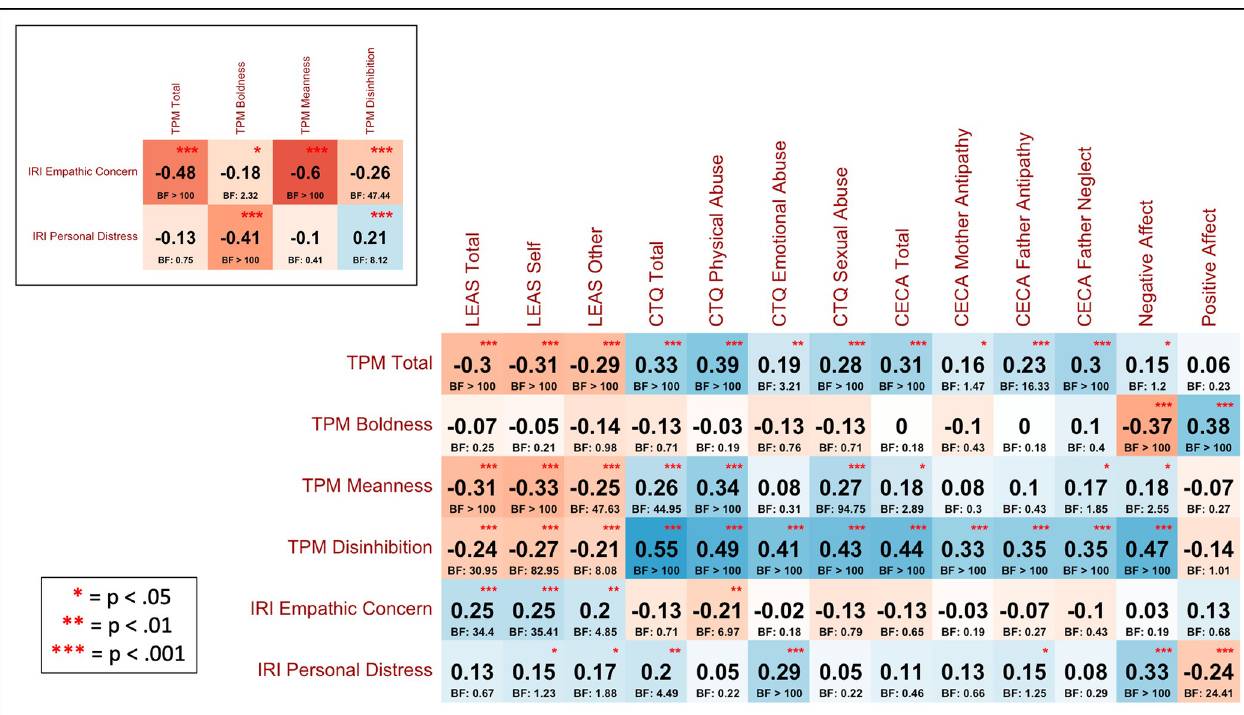
Fig 3. Correlations between measures. This figure shows post-hoc correlations (and associated BFs) across the full sample between additional subscales, illustrating their contributions to the main findings described in the text. Measures include the Levels of Emotional Awareness scale (LEAS), Triarchic Psychopathy Measure (TPM), Interpersonal Reactivity Index (IRI), Childhood Experiences of Care and Abuse questionnaire (CECA), Childhood Trauma Questionnaire (CTQ), and the Positive and Negative Affect scales from the Positive and Negative Affect Schedule